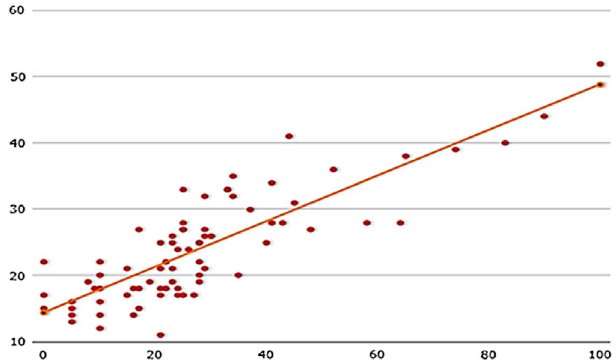
Figure 3. Distribution of migration percentage (MP) and acetabular index (AI) after